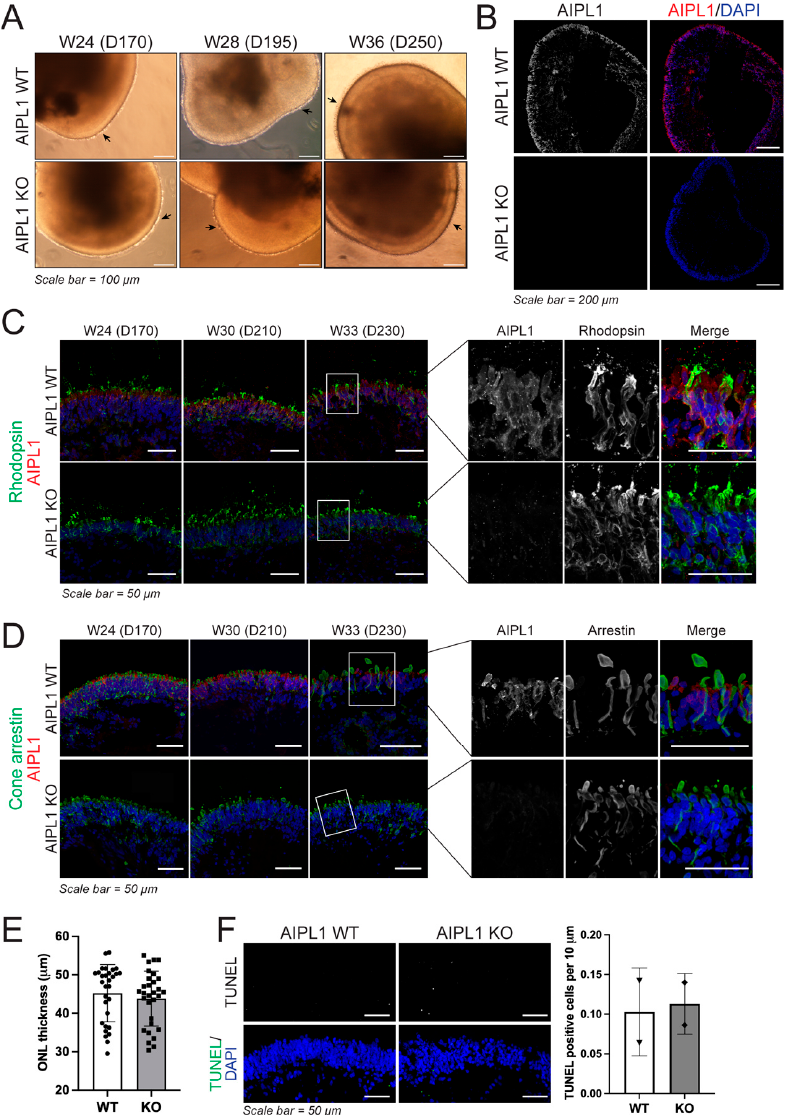
Figure 2. Isogenic AIPL1 WT and KO iPSC generate retinal organoids (RO) with comparable structures during differentiation. ( A ) Brightfield images of developing AIPL1 WT and AIPL1 KO RO (week (W) 24–36, day (D) 170–250). A well-developed brush border of presumptive OS/IS photoreceptor structures is seen on the surface of RO from D170 (arrow). Scale bars = 100 µm. ( B ) AIPL1 KO RO (D230) had no detectable AIPL1 protein (red) compared to AIPL1 WT RO. Scale bars = 200 µm. ( C ) The development of rhodopsin-positive rod photoreceptors (green) was comparable in AIPL1 WT and AIPL1 KO RO at D170 (W24), D210 (W30) and D230 (W33), despite the loss of AIPL1 protein (red) in AIPL1 KO RO. Scale bars = 50 µm. The white rectangles demarcate the highlighted regions in the panel to the right. ( D ) The development of cone arrestin-positive cone photoreceptors (green) was comparable in AIPL1 WT and AIPL1 KO RO at D170 (W24), D210 (W30) and D230 (W33), despite the loss of AIPL1 protein (red) in AIPL1 KO RO. Scale bars = 50 µm. The white rectangles demarcate the highlighted regions in the panel to the right. ( E ) ONL thickness was unaltered between AIPL1 WT and KO RO (W33, D230). Each dot represents an individual measurement, shown as mean +/ − SD with significance determined by unpaired t test. ( F ) Apoptotic cells detected by TUNEL assay and number of positive cells per 10 µm of RO ONL. A total of 2 RO were included per timepoint and condition, shown as mean +/ − SD with significance determined by unpaired t test.